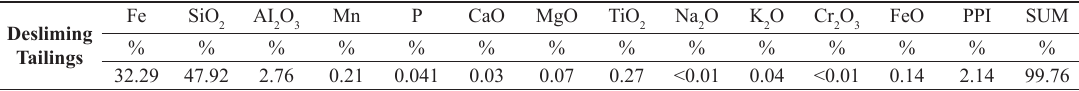
Table 1. Chemical composition of the desliming tailings sample. Desliming Tailings